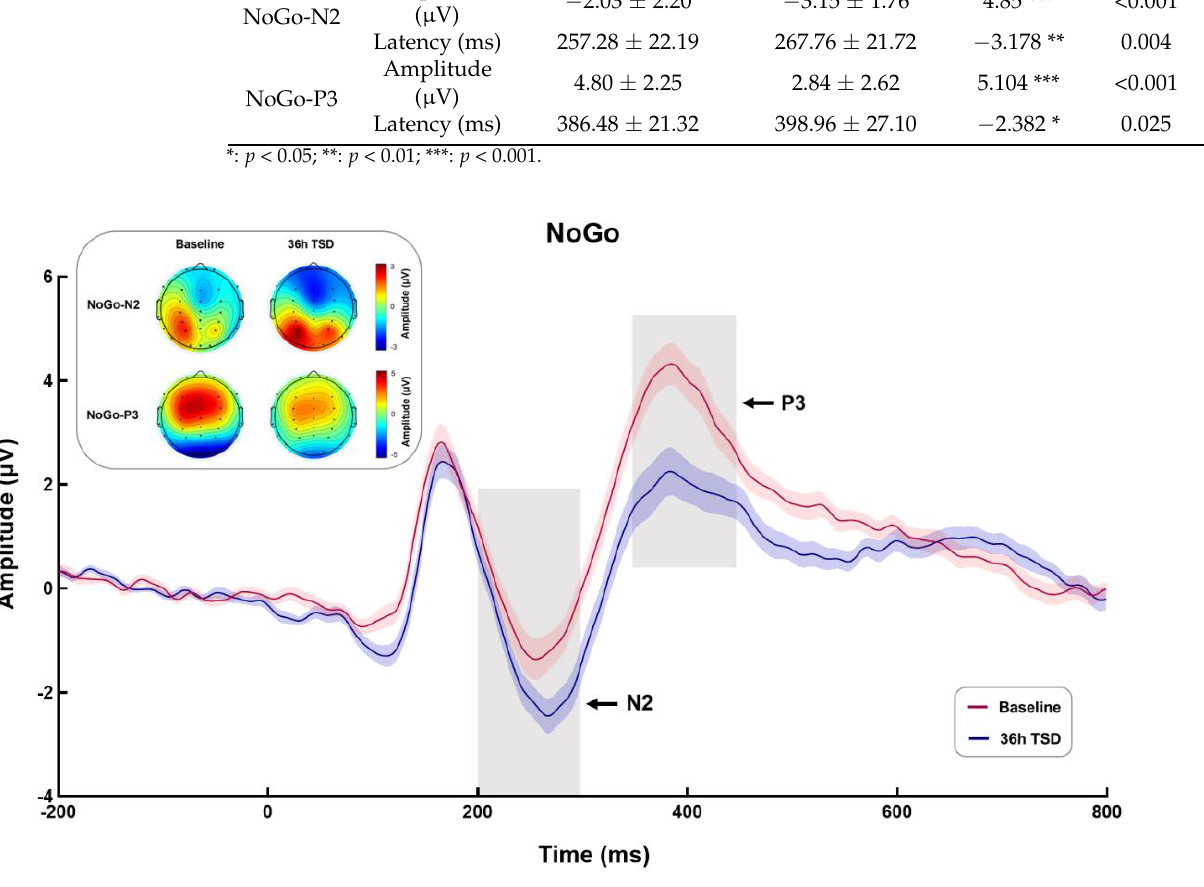
Figure 4. Event-related potential (ERP) and topographic maps of NoGo-N2 (200 – 300 ms) and NoGo- P3 (350 – 450 ms) at baseline and 36-h total sleep deprivation (TSD). ERP was calculated by averaging the data at Fz, F3, F4, FCz, FC3, and FC4 electrodes. The red and blue curves represent the ERP for the baseline and 36-h TSD conditions, respectively; the shaded area around each line represents the standard deviation of the signal divided by the square root of the number of channels. Table 2. Amplitude and latency (mean ± standard deviation) of NoGo-N2 and NoGo-P3 at baseline and 36-h total sleep deprivation (TSD) and t -test results.